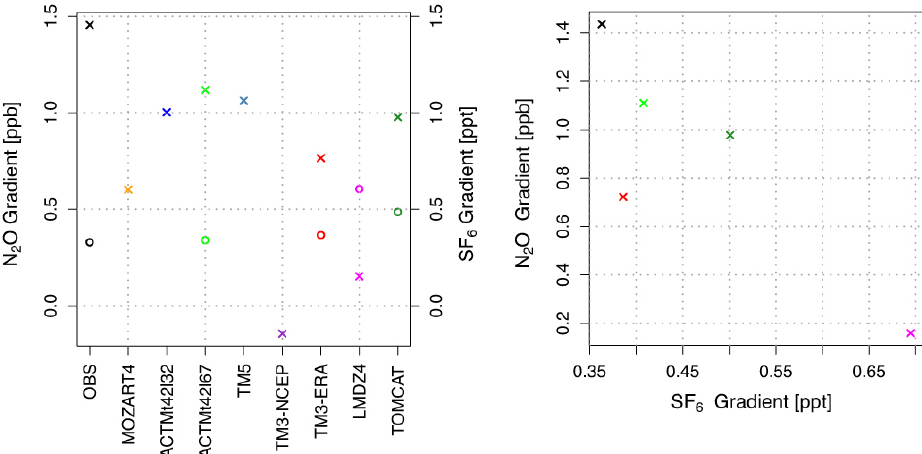
Fig. 6. Comparisons of modelled and observed north–south gradients of N 2 O and SF 6 . N 2 O was simulated using the flux scenario, OCNPIC. Gradients are calculated as the mean of values for all background sites north of 20 ◦ N minus the mean of all values for sites south of 20 ◦ S. The left panel shows the N 2 O (crosses) and SF 6 (circles) gradients for the observations and each model. The right panel shows the N 2 O gradient versus the SF 6 gradient. Legend: Mozart4, yellow; ACTMt42l32, blue; ACTMt42l67, green; TM5, grey-blue; TM3-NCEP, purple; TM3-ERA, red; LMDZ4, magenta; TOMCAT, dark green; observed,